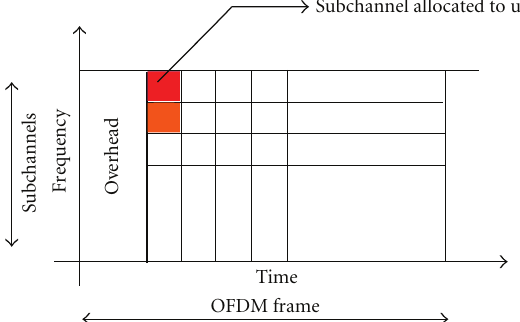
Figure 6: OFDM subchannel allocation with respect to time.